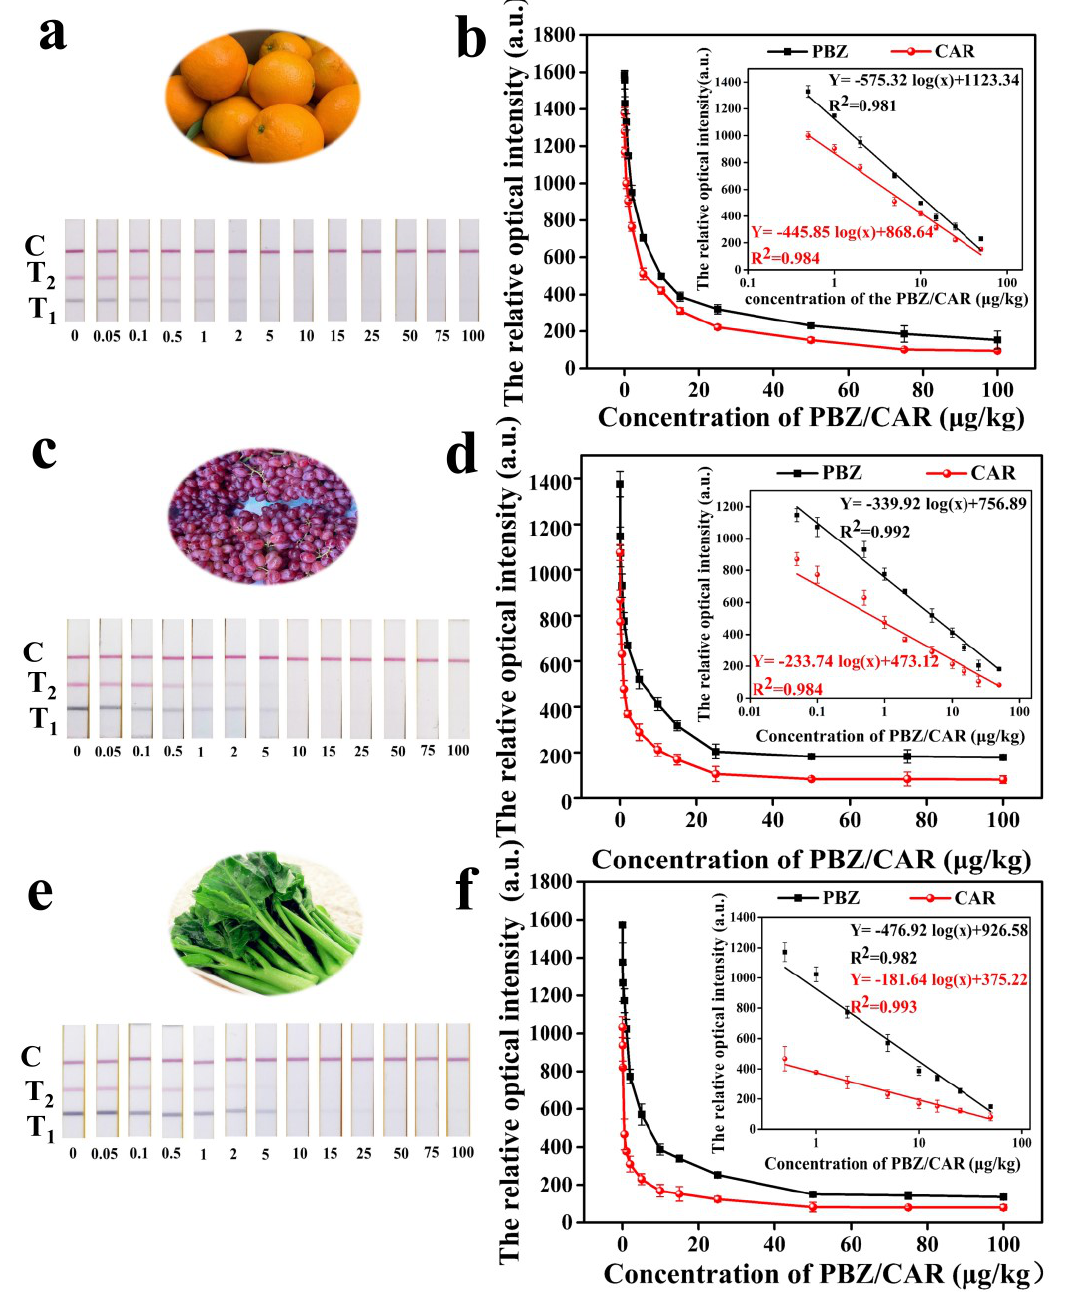
Figure 4. Simultaneous detection of PBZ and CAR based on dual-color ICA. ( a ) Images of simulta- neous detection of PBZ and CAR in orange, ( b ) standard curves of simultaneous detection of PBZ and CAR in orange. ( c ) Images of simultaneous detection of PBZ and CAR in grape, ( d ) standard curves of simultaneous detection of PBZ and CAR in grape. ( e ) Images of simultaneous detection of PBZ and CAR in cabbage mustard, ( f ) standard curves of simultaneous detection of PBZ and CAR in cabbage mustard.